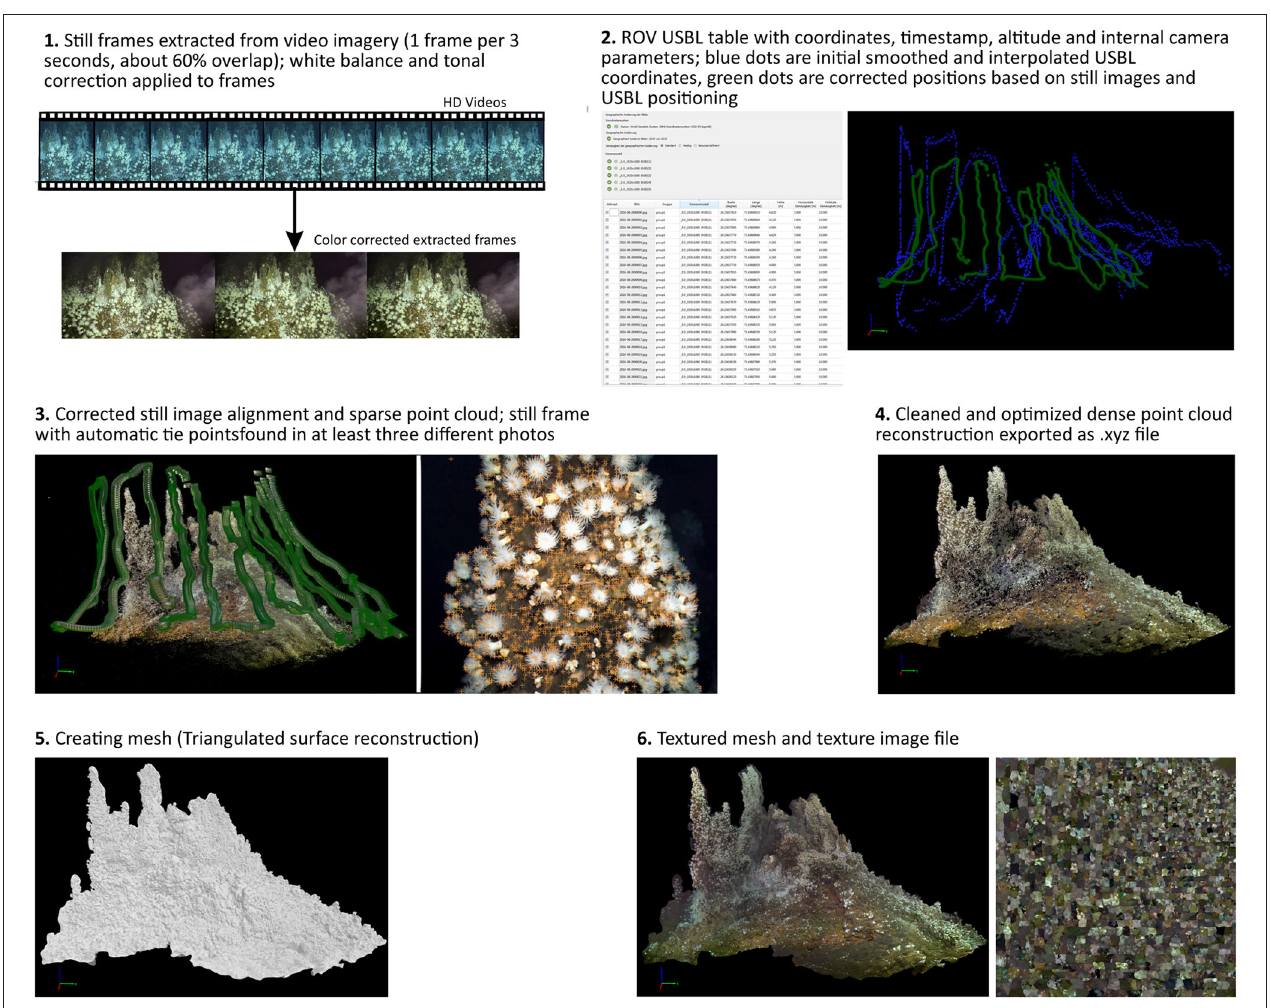
FIGURE 2 | Workflow of the 3D reconstruction from HD video footage to textured mesh.